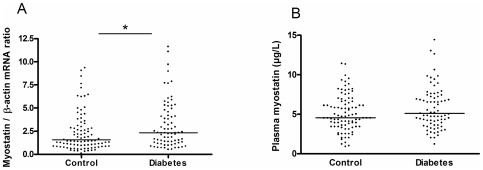
Skeletal muscle mRNA content (A) and plasma myostatin (B) in healthy control (n = 92) and patients with type 2 diabetes (n = 76).Individual data are presented and the bar indicates the geometric mean. * indicates a significant difference between healthy controls and patients with type 2 diabetes, P<0.05.